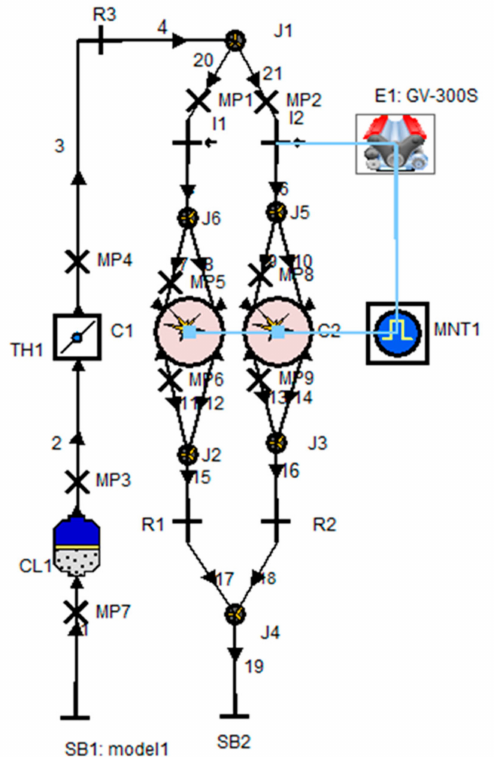
Figure 3. Engine simulation model